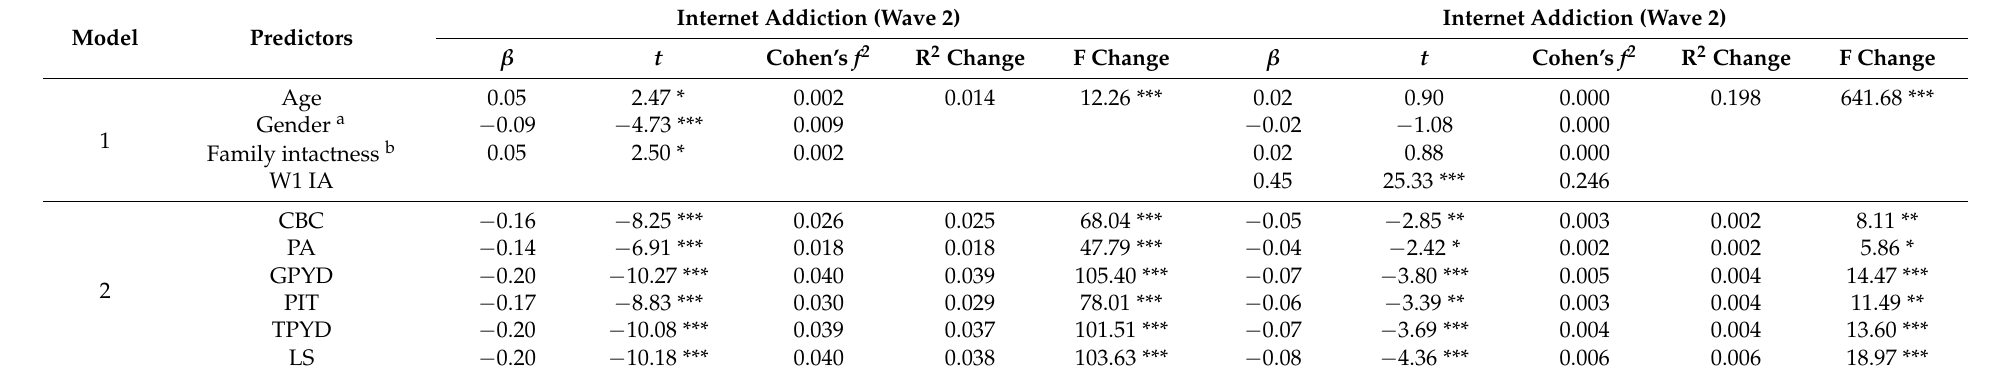
Table 4. Longitudinal regression analyses for Internet addiction.